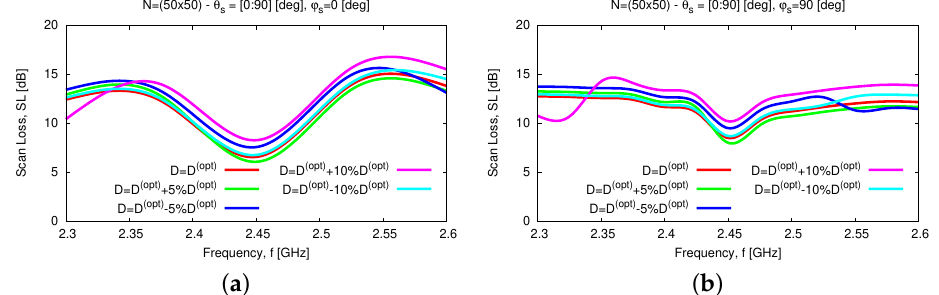
Figure 16. Numerical Assessment ( [ f min , f max ] = [ 2.3, 2.6 ] [GHz]— N = ( 50 × 50 ) )— SL performance versus frequency when steering the beam towards θ s ∈ [ 0, 90 ] [deg] and ( a ) ϕ s = 0 [deg] or ( b ) ϕ s = 90 [deg] and assuming that the height of the parasitic element, D , is affected by manufacturing deviations of ± 5% and ± 10% from the nominal value D ( opt ) (Table 2). Similar conclusions can be drawn when taking into account fabrication tolerances on ( opt ) + ( ξ × ν ) , ν = 0.35 [ µ m] being the according to the following rule: W f / r = W f / r metallization thickness and ξ ∈ {− 1.0; − 0.5; + 0.5; + 1.0 } . The effects of such